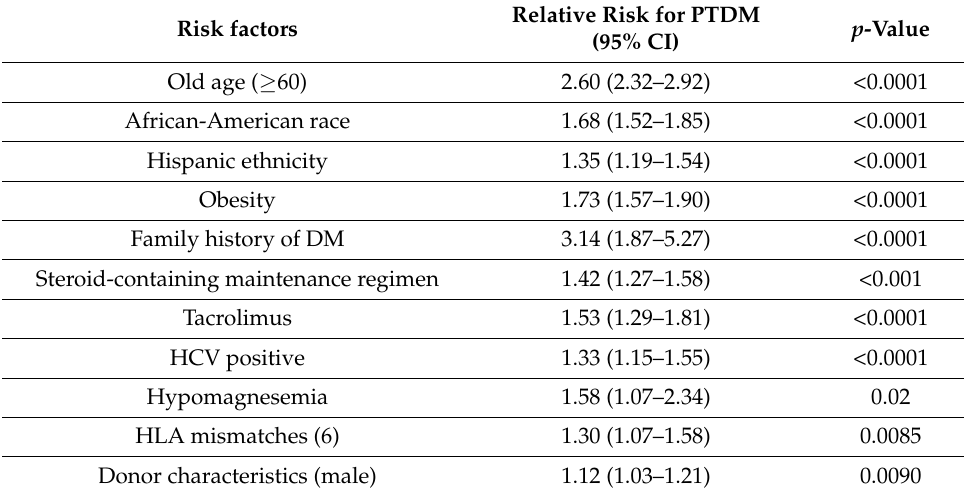
Table 2. Risk factors for PTDM